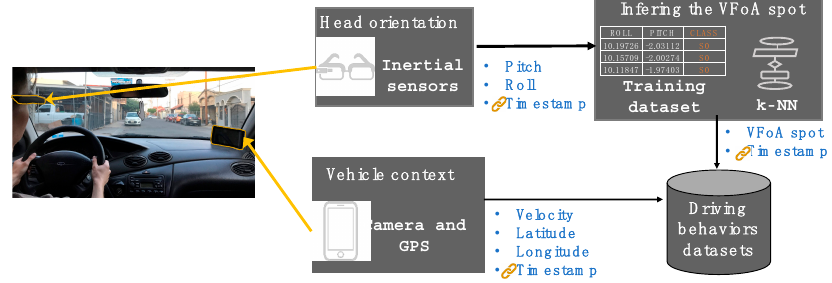
Figure 1. Sensing